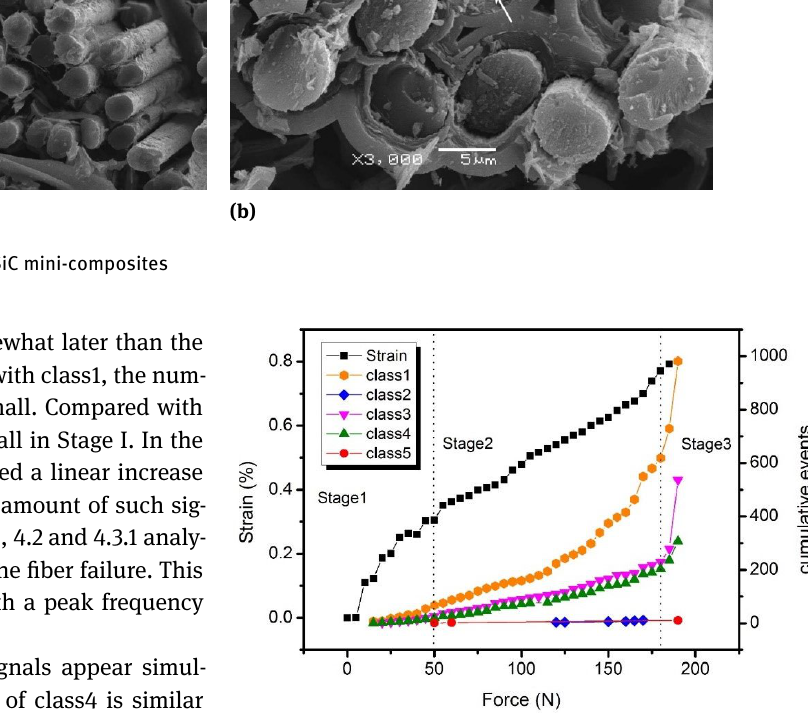
Figure 26: Cumulative events of AE signals for each cluster for In- situ tensile